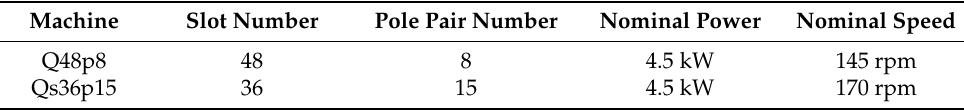
Table 1. Main parameters of the considered